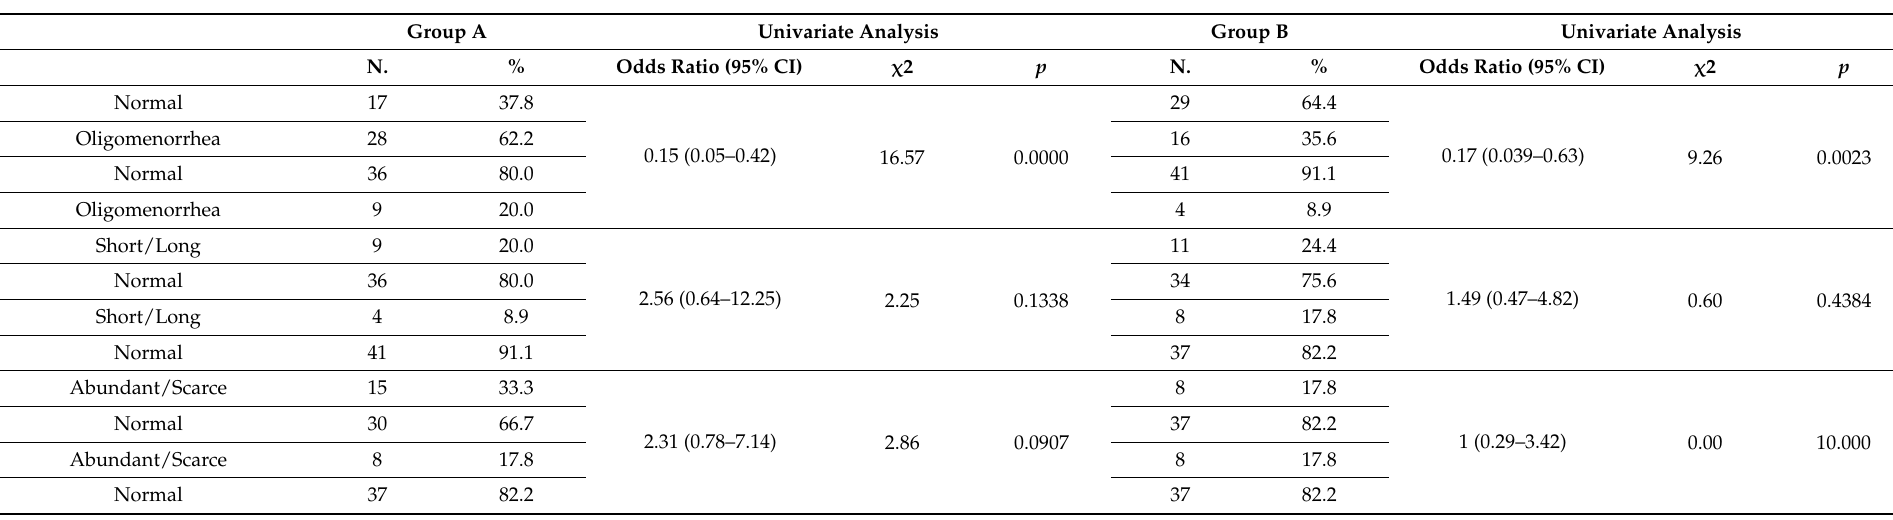
Table 2. Comparison of menstrual frequency, duration of the cycle, the amount of the menstrual cycle, dysmenorrhea, and dyspareunia in long-term survivors of lymphoma between baseline (T0) and after 12 months (T12) of follow-up with (Group A) and without nutritional supplement (Group B). Group A Univariate Analysis Group